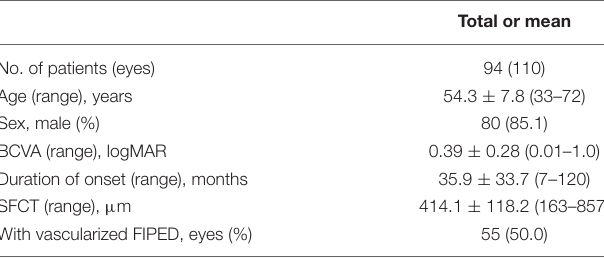
TABLE 1 | Summary of the clinical and demographic features of included chronic CSC with FIPED.